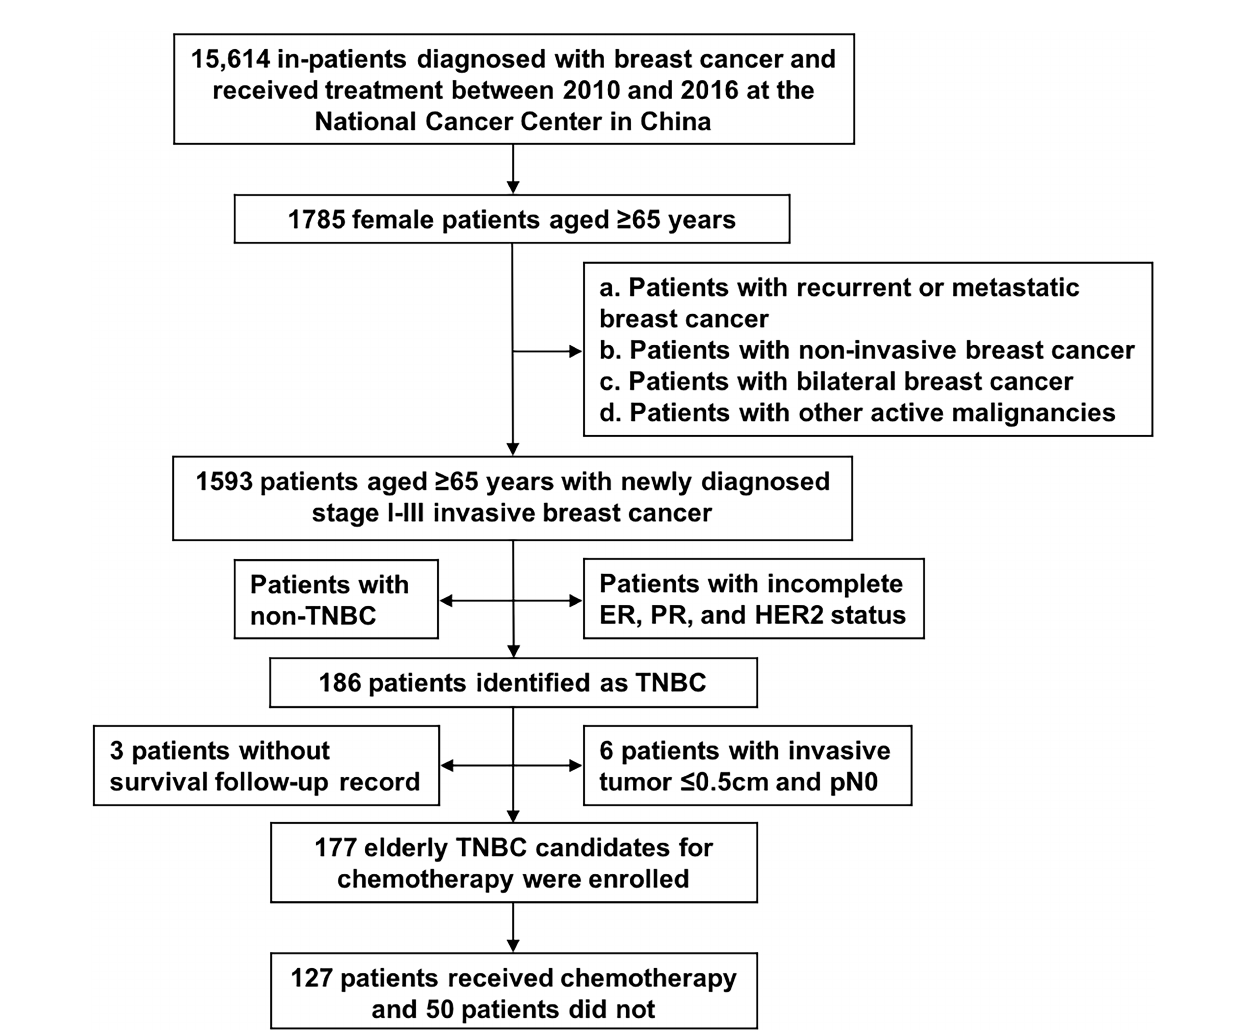
FIGURE 1 | Flowchart of patient selection. ER, estrogen receptor; HER2, human epidermal growth factor receptor 2; PR, progesterone receptor; TNBC, triple- negative breast